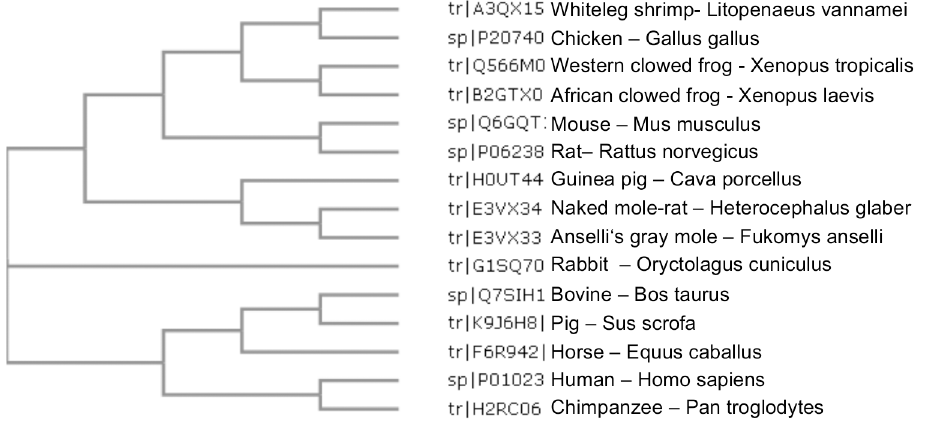
Fig 1. Phylogenetic tree of A2M. Phylogenetic analysis of A2M protein sequences was done using the ClustalW2 onlinetool (https://www.ebi.ac.uk/Tool/phylogeny/clustalw2phylogeny). The compared A2M protein sequences were readout from the Uniprot